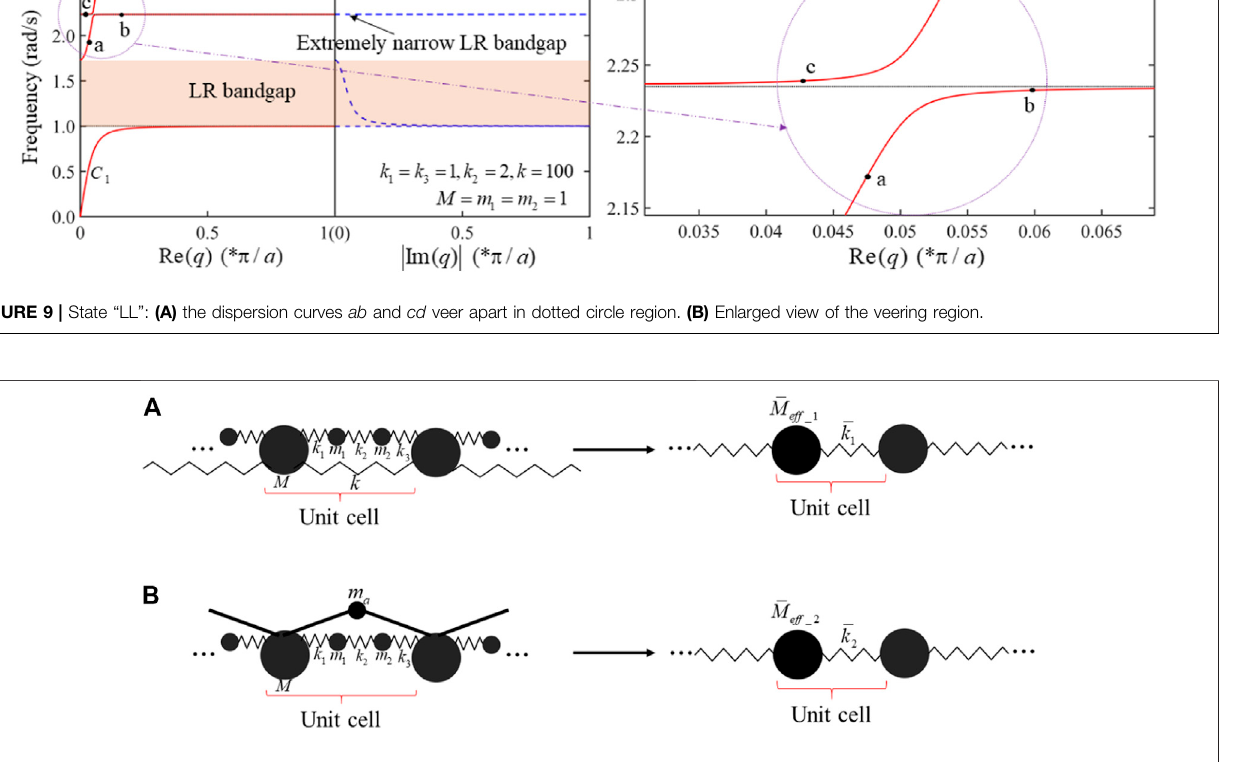
FIGURE10| Schematicdiagramsoftheeffectivemonatomicchainsfor (A) themass-coupledmonatomic/triatomicchain(3-DOF),and (B) theinertialampli fi cation system of 3-DOF.